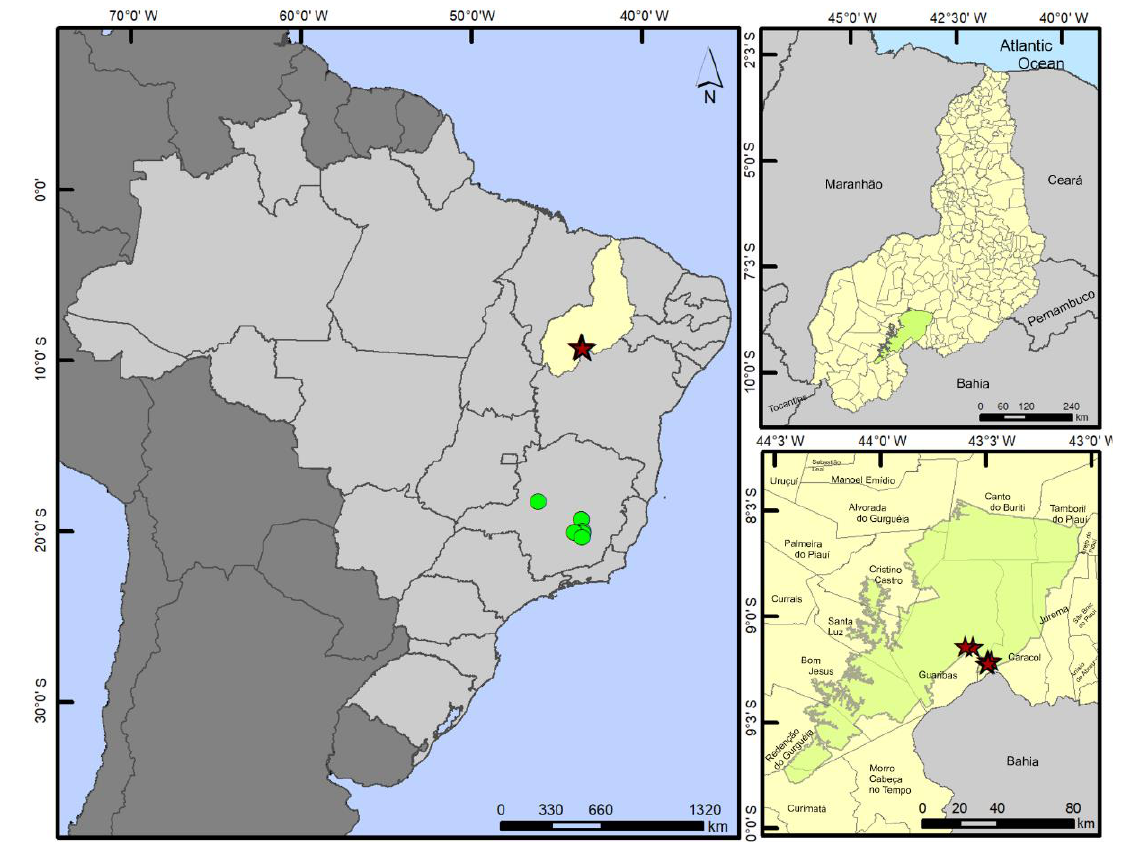
Figure 10. Paravelia nieseri from Piauí state, macropterous males, habitus. ( A , C ). Dorsal view. ( B ). Ventral view. Scale bars: 2 mm.